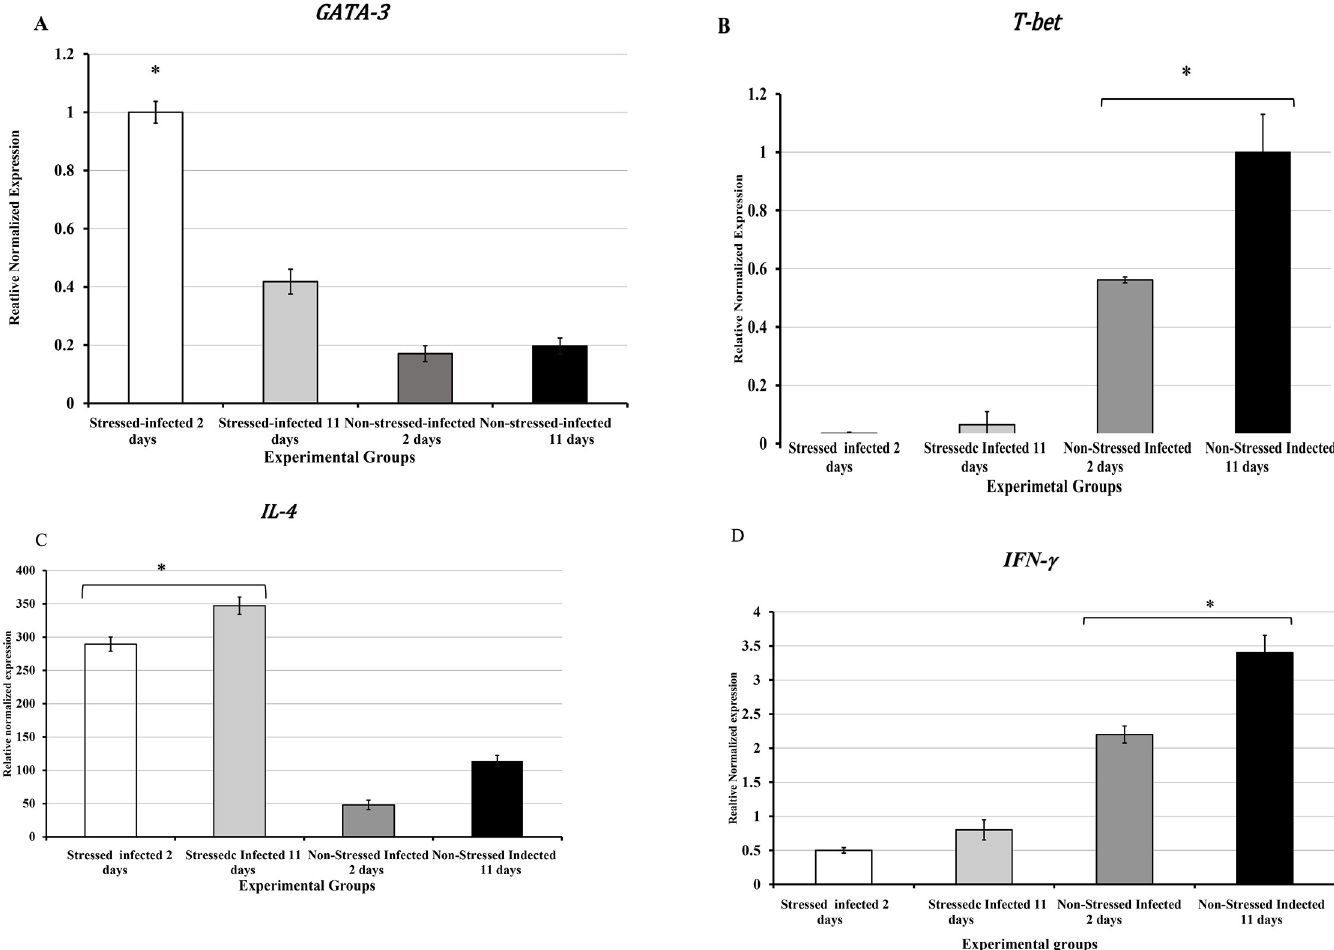
Fig 5. The persistence of the effect of CIS on the modulation of transcription factors and signature cytokines of Th1 and Th2 cells in the genital tract of stressed/ non-stressed mice. Gene expression of A ), GATA-3, B ) T-bet, IL-4 C ), and D ) IFN- γ during two or 11-days post- C . muridarum genital infection relative to non- infected mice. Results are mean +/- SEM of two independently performed experiments. � Denotes significant statistical differences between treatment groups at the level of (p < 0.05).